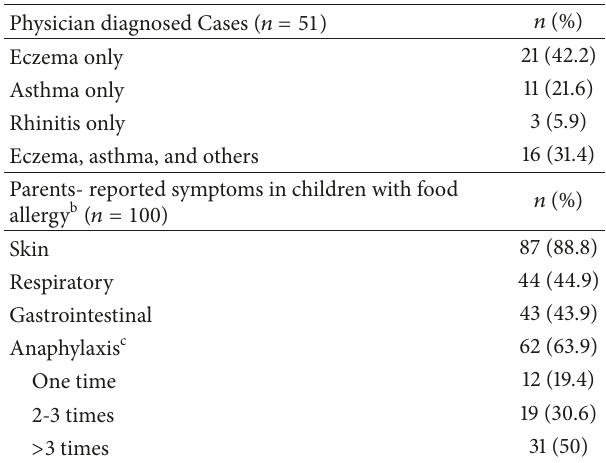
Table 2: Prevalence of other atopic diseases among confirmed a FA cases.